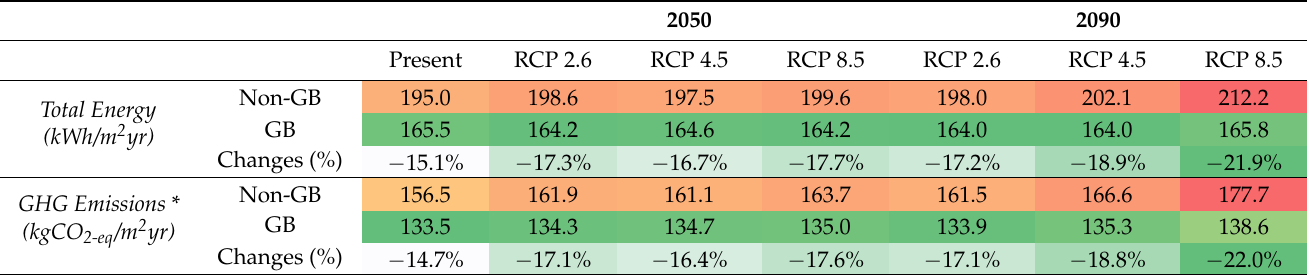
Table 4. Total energy use and greenhouse gas emissions for both GB and